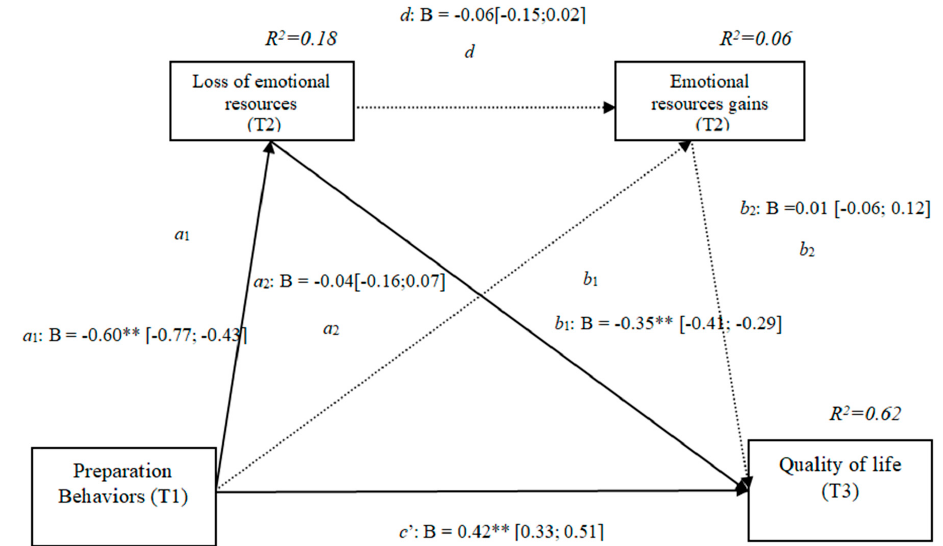
Figure 7. Non-standardized B coefficients, confidence intervals, and statistical significance for emotional losses and gains. Note: [95% CI]; * p < 0.05; ** p < 0.01.